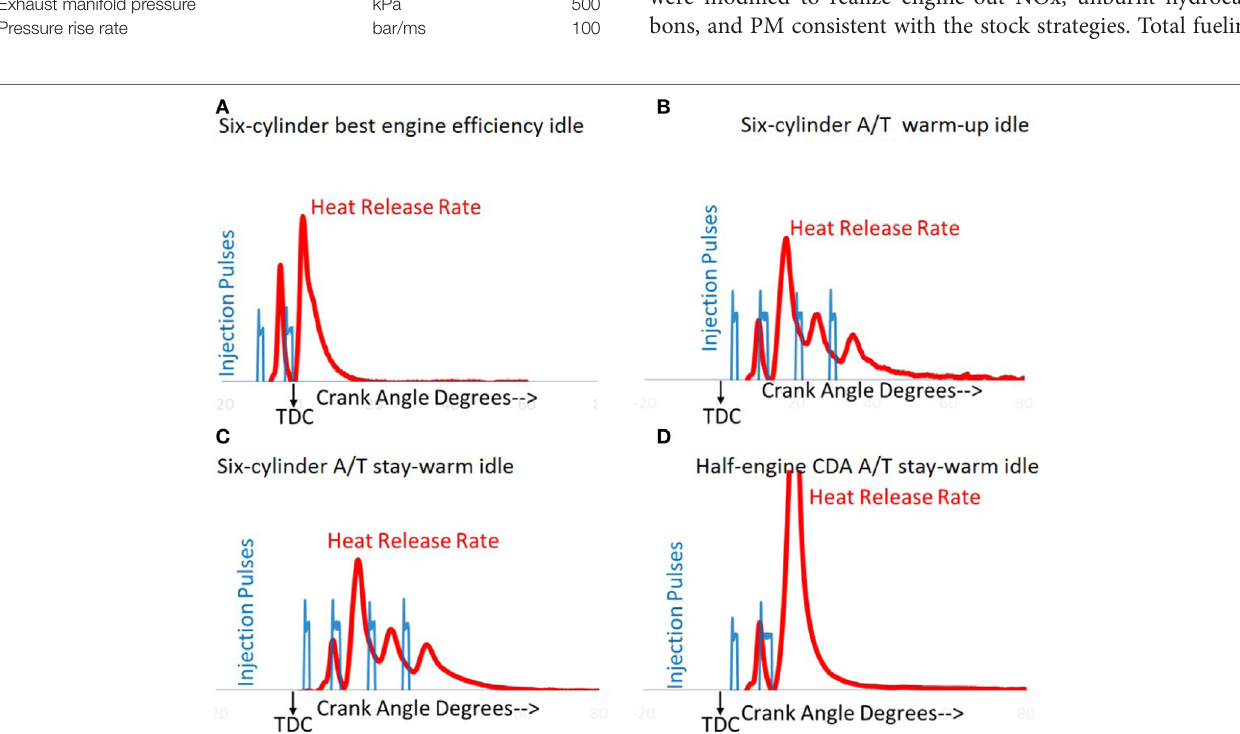
FigUre 7 | Experimental fuel injector current and heat release for the four strategies during 800 RPM/1.3 bar operation. The “Six-cylinder best engine efficiency idle” strategy (a) has two early injections while strategies involving six-cylinder operation in thermal management strategy (B,c) have four late injections to obtain elevated turbine-outlet temperature. Two delayed injections are used for the “Half-engine CDA A/T stay-warm idle” strategy (D) to maintain desirable A/T temperatures in a fuel-efficient